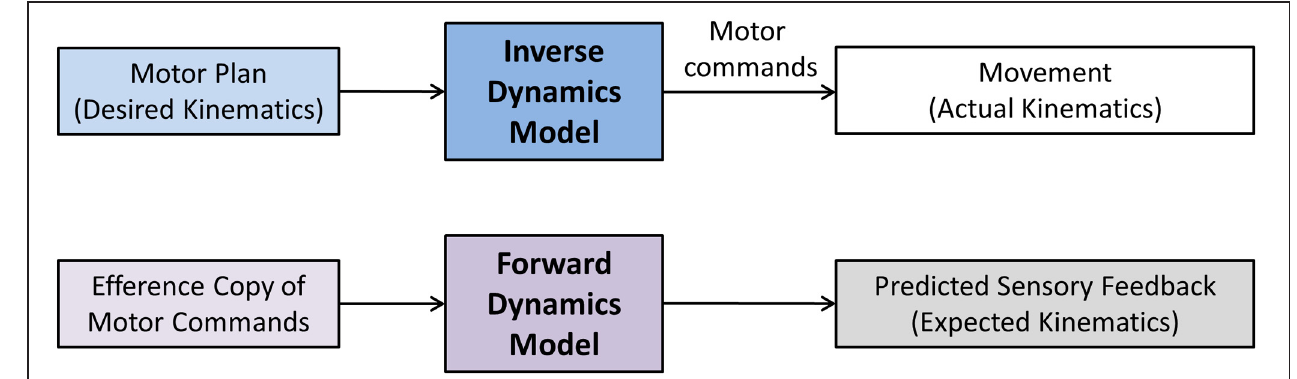
FIGURE 3 | Sensorimotor and motor-sensory transformations performed by inverse and forward dynamics models. The term dynamics refers to Newtonian dynamics. That is, the transformation is between kinematics (movement) and kinetics (underlying forces). Here, a motor plan specifies the desired kinematics of the movement (desired trajectory, speed, acceleration). An inverse dynamics model transforms